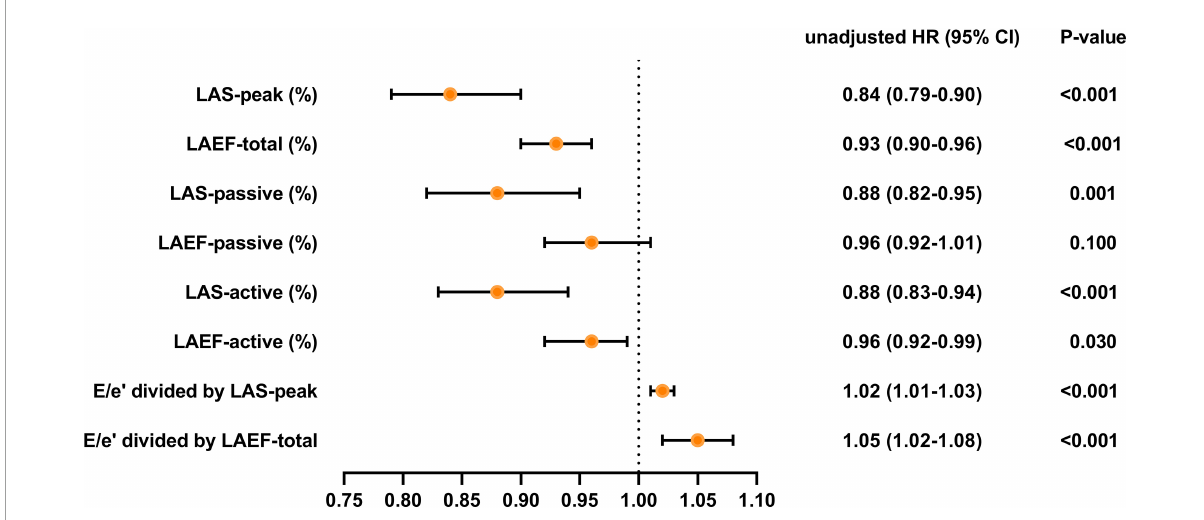
FIGURE3 Unadjusted HR for various measures of LA function and stiffness HR, hazard ratio; LA, left atrial; LAS, LA strain; LAEF, LA ejection